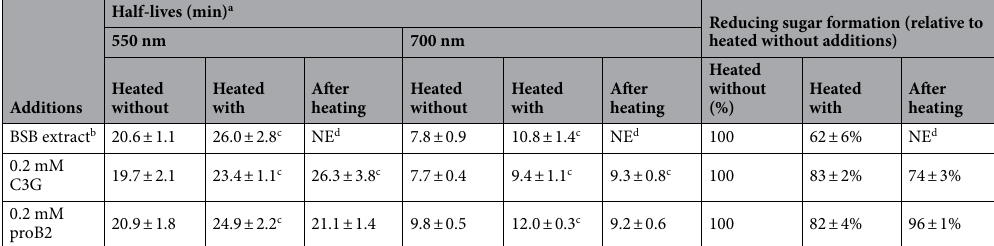
Table 1. Effects of BSB extract, C3G, and proB2 on pancreatin-induced hydrolysis of amylose. a The values were determined as Fig. 1 b Concentration of C3G in BSB extract, 0.2 mM. c Significant difference between “Heated without” and “Heated with”, and between “Heated without” and “After heating”. p < 0.05 (n = 3). d Not